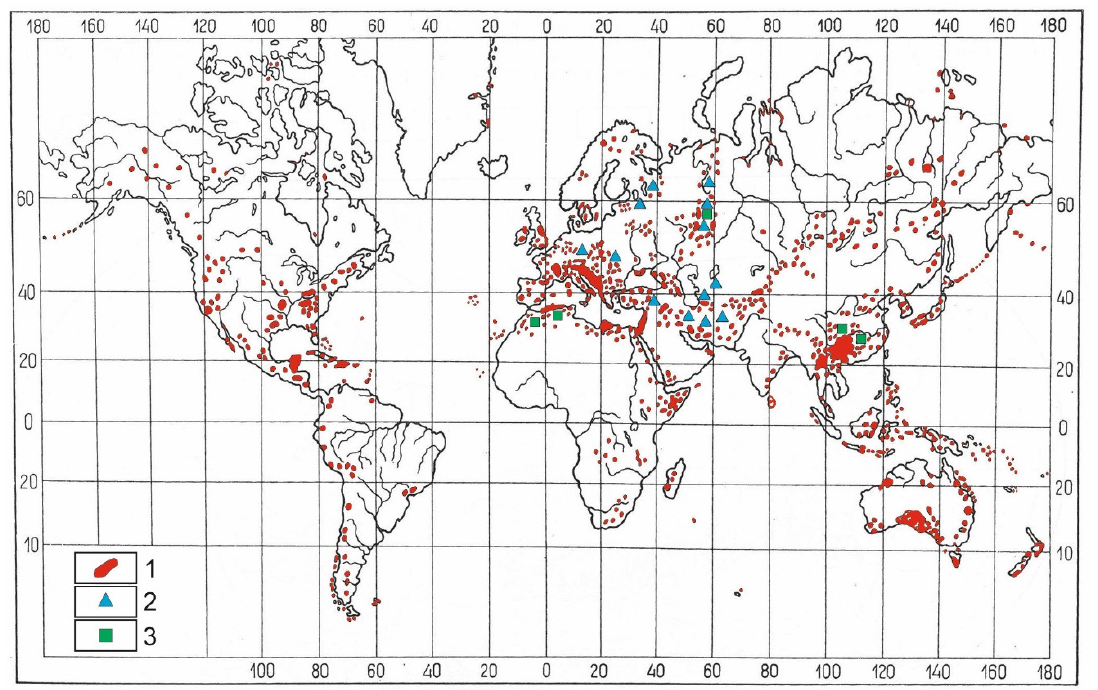
Figure 1. The Earth’s karsts [6]. Legend: 1. limestone karst, 2. gypsum karst, 3. halite karst.